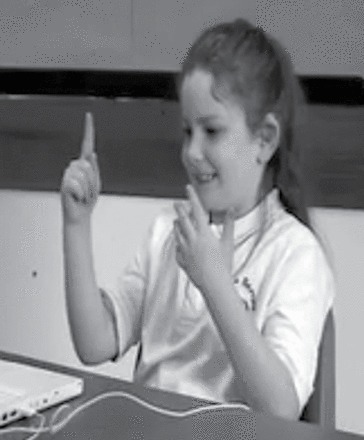
Whole entity construction. The signer’s right hand represents the Pink Panther arriving.